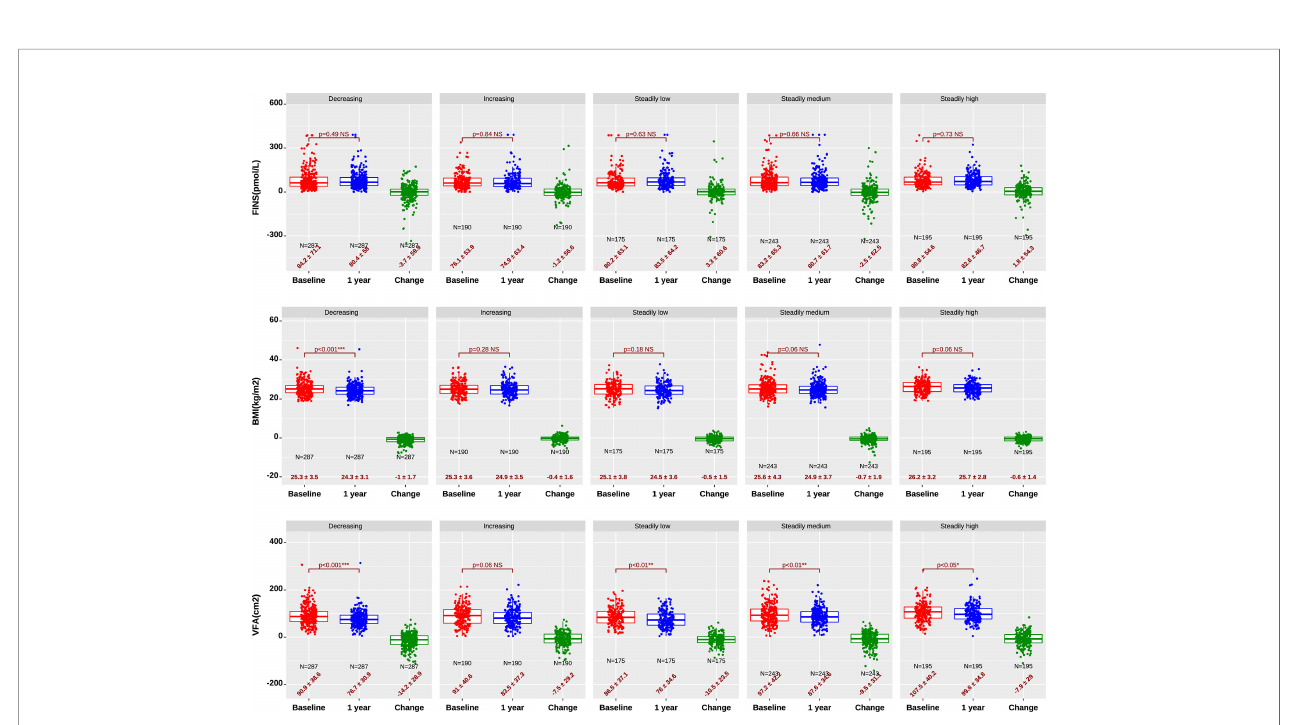
FIGURE 2 | Fasting insulin(top), BMI(mid), and VFA (bottom) at baseline and after one-year treatment. The fasting insulin in the steadily low salt group showed a minor increase after treatment. Decreasing and steadily low salt intake leads to lower BMI and VFA, as well as a larger decrease in BMI and VFA after treatment. *, signi fi cant with p<0.05; **, signi fi cant with p<0.01; ***, signi fi cant with p<0.001; NS, not signi fi cant with p>0.05.